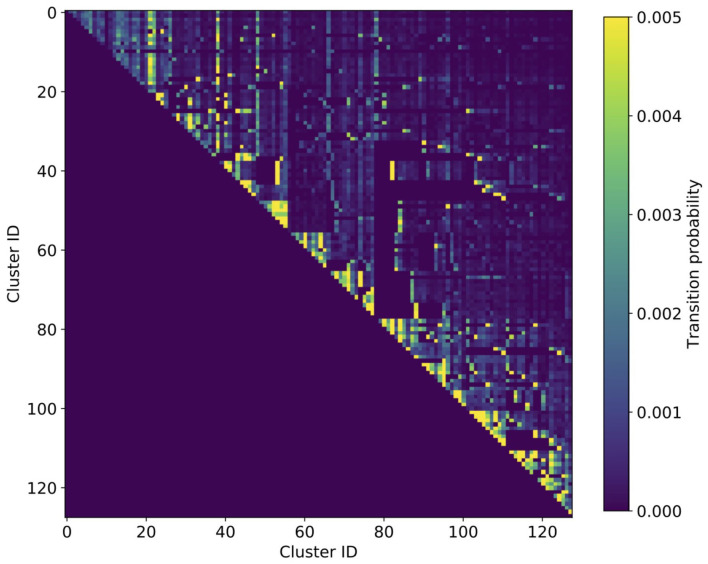
Heatmap of cluster transition rates aggregated over age and sex. The transition matrix is of triangular shape, meaning that there is a by construction hierarchical order of how patients progress in their multimorbid health states. The multi-level hierarchy is clearly discernible by the triangular blocks with increased transition rates along the diagonal, the macro-clusters.